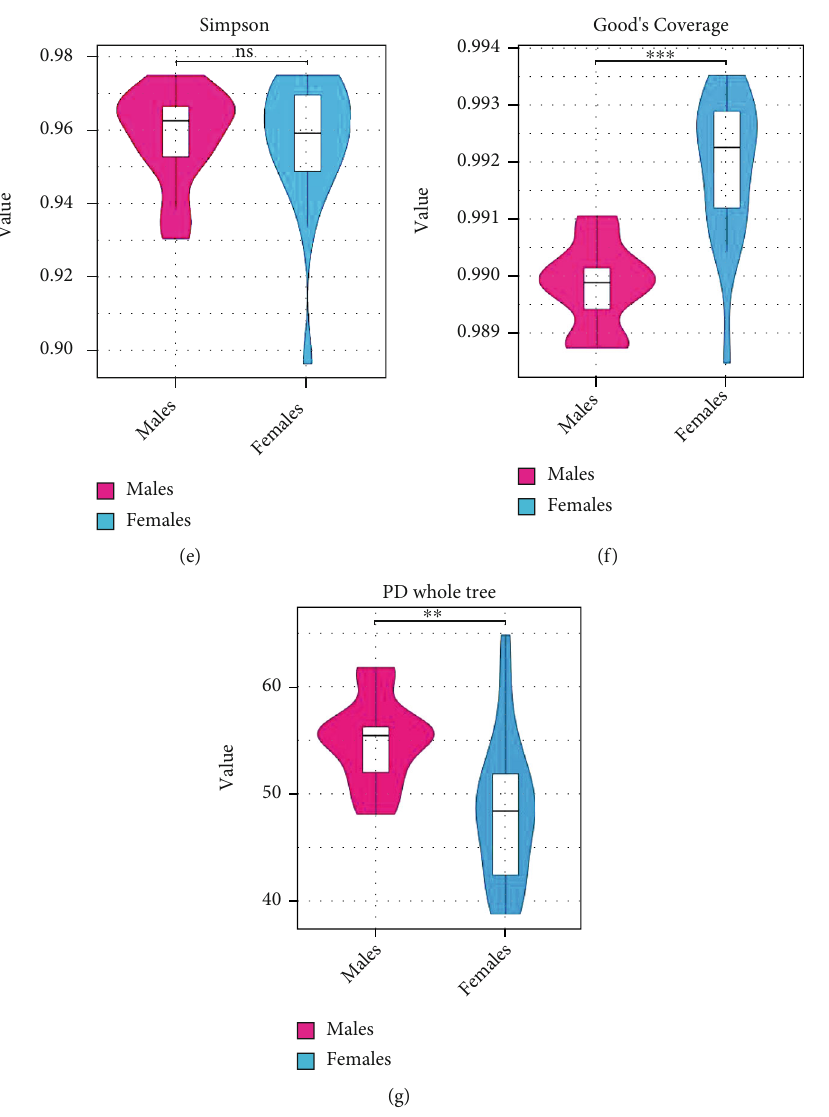
Figure 1: Venn diagram and α -diversity analysis of elderly males and females with stage 1 periodontitis. (a) Venn diagram based on operational taxonomic units (OTUs). (b – g) Violin plots comparing α -diversity indices (Chao1, observed species, Shannon index, Simpson index, Good ’ s coverage, and PD whole tree) between males and females. ∗∗∗ P < 0 : 001 ; ∗∗ P < 0 : 01 ; ns: not signi fi